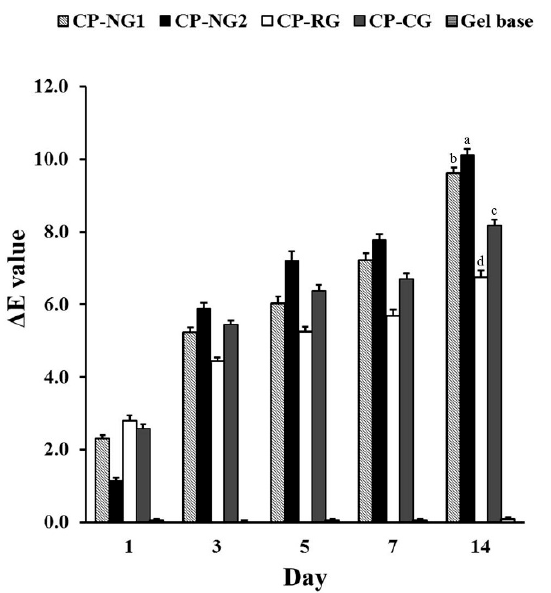
Figure 6. Ex vivo tooth bleaching efficacy of CP-NG in comparison to CP-RG, CP-CG, and gel base. Different lowercase letter implied the statistically different ( p < 0.05).